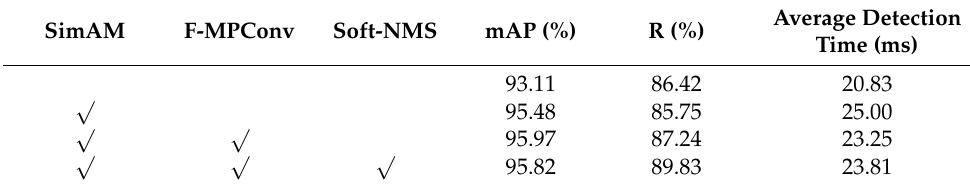
Table 3. Ablation